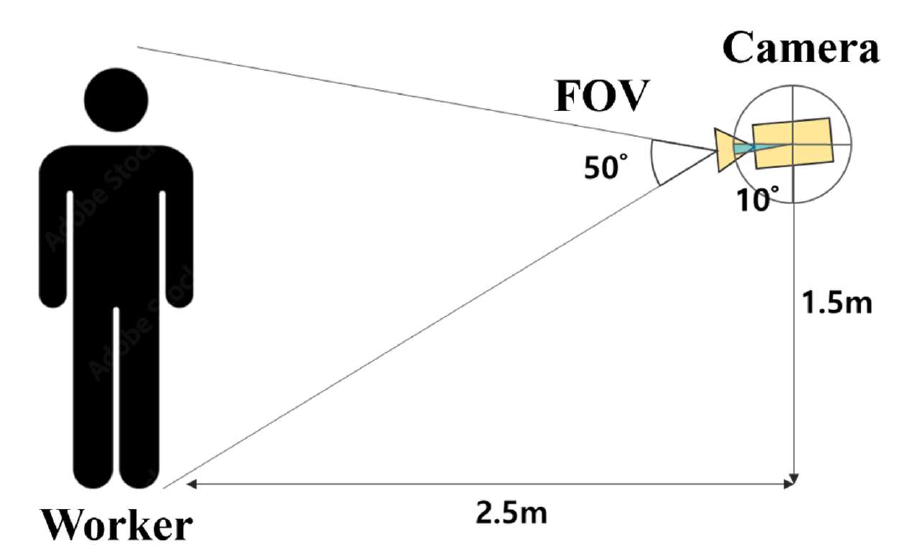
Figure 19. Camera angle and distance.